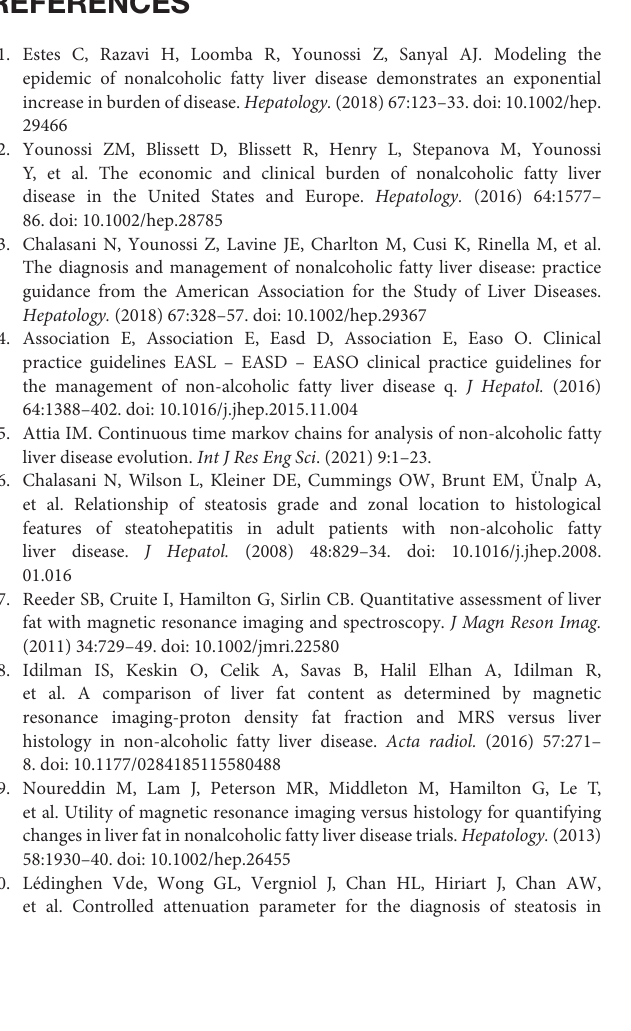
Supplementary Data-sheet 1 | Excel sheet for the timeline of the participants. Supplementary Data-sheet 2 | Supplementary material for the simple data model.